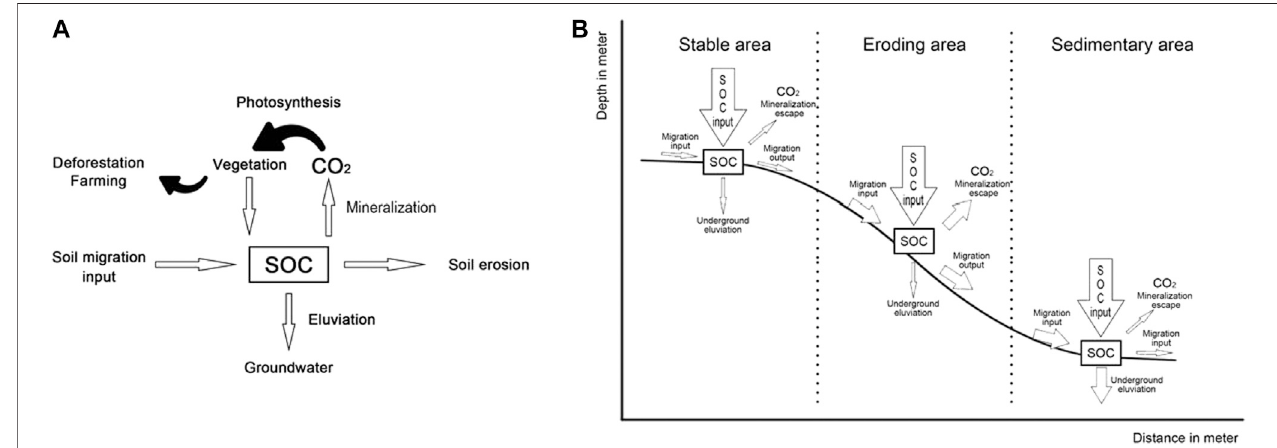
FIGURE 6 | (A) SOC cycle pattern. SOC reserves depend mainly on a dynamic balance between input and output. For SOC in a certain area, SOC input includes largelysoil migration inputbecauseofsoil erosion and organic carbon contained inthe vegetation litter; SOC output includes largelysoil migration output becauseofsoil erosion, mineralization, and dissolution of active parts of SOC. The carbon dioxide (CO 2 ) in the atmosphere is fi xed by photosynthesis to achieve carbon circulation. (B) SOC migration pattern in stable, eroding, and sedimentary areas along the slopes in response to vegetation restoration. The thickness of the arrows indicates the amount of SOC